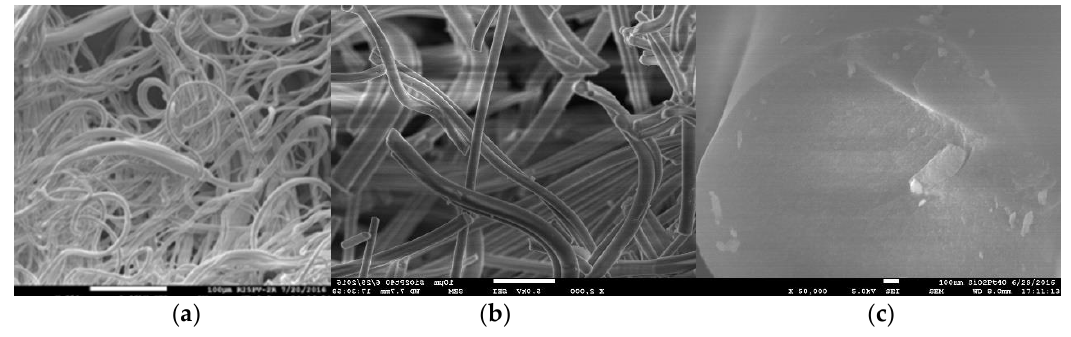
Figure 16. Micro shots of SEM precursor SiO 2 nanofibers over flare ( a ) and porous SiO 2 nanofibers after firing at 250× magnification ( b ) and 2000× magnification ( c ).